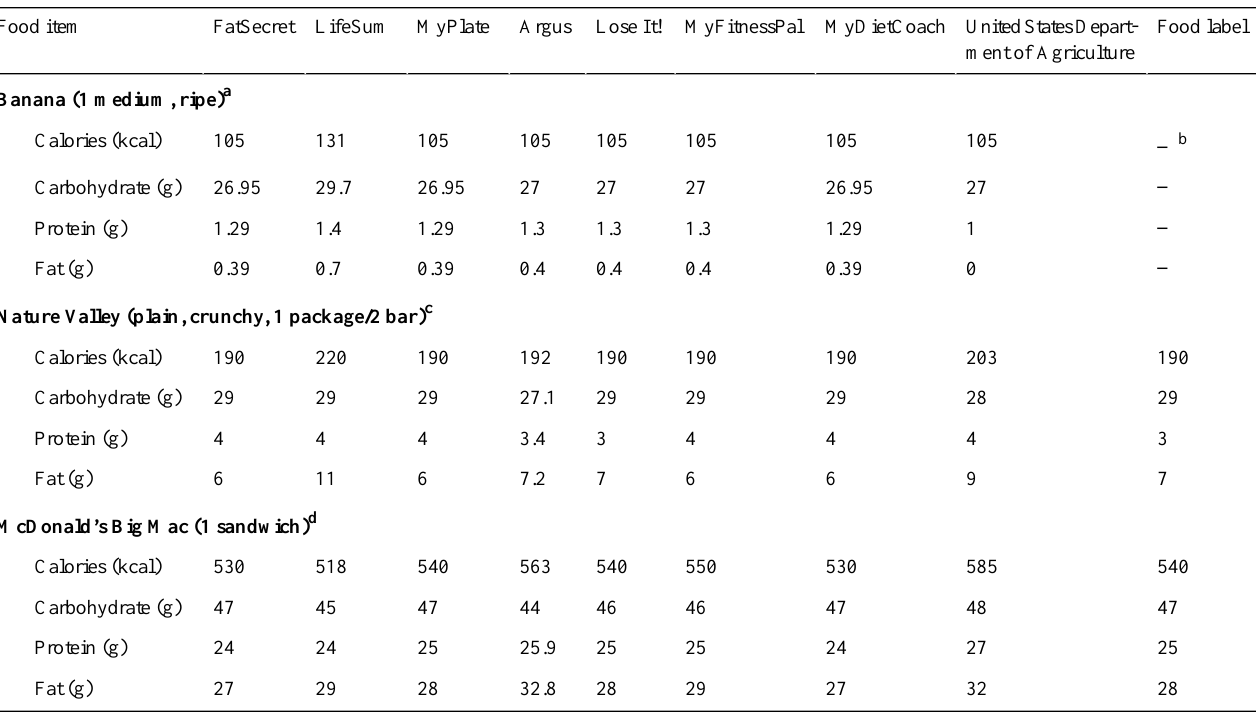
Food labelUnited States